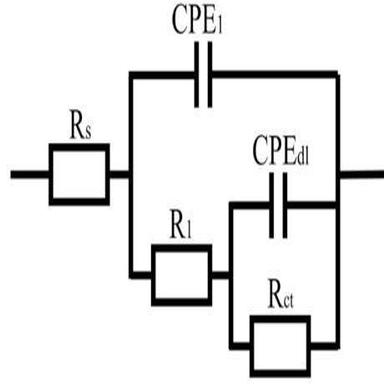
Equivalent circuit for EIS simulation.